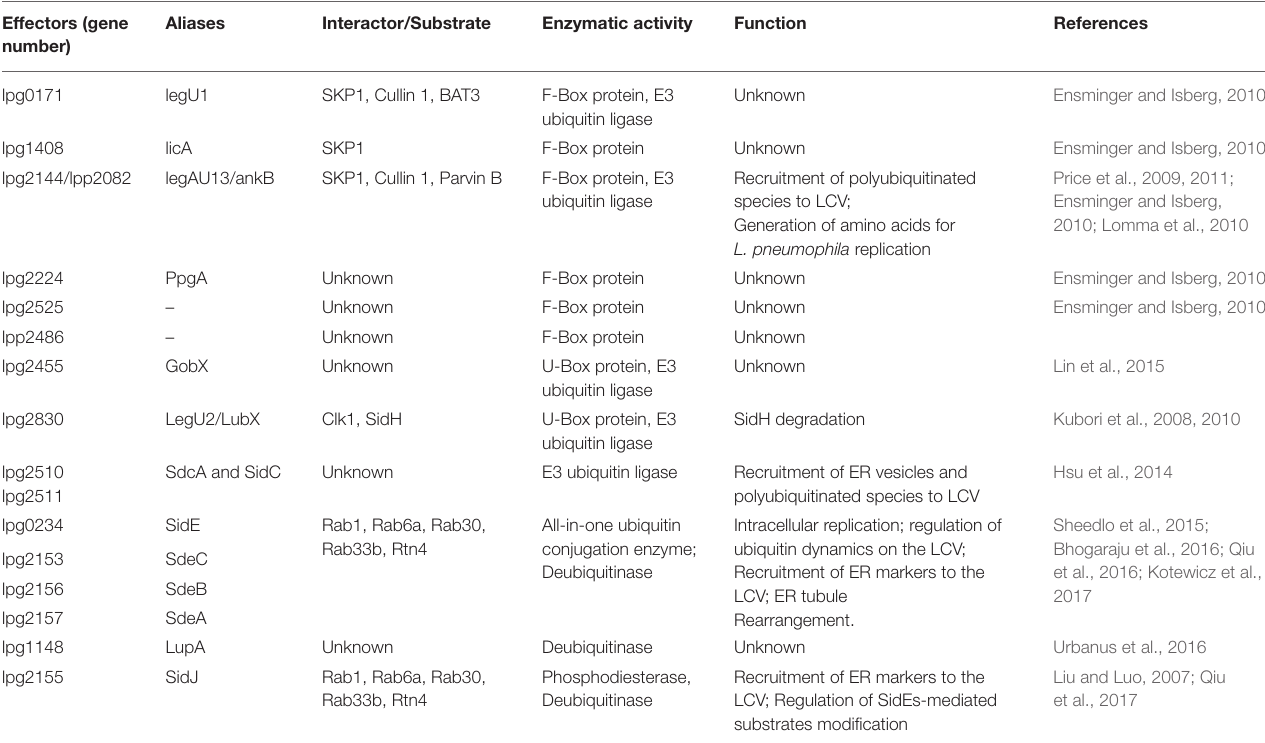
TABLE 1 | L. pneumophila Dot/Icm effectors involved in ubiquitination. Effectors (gene